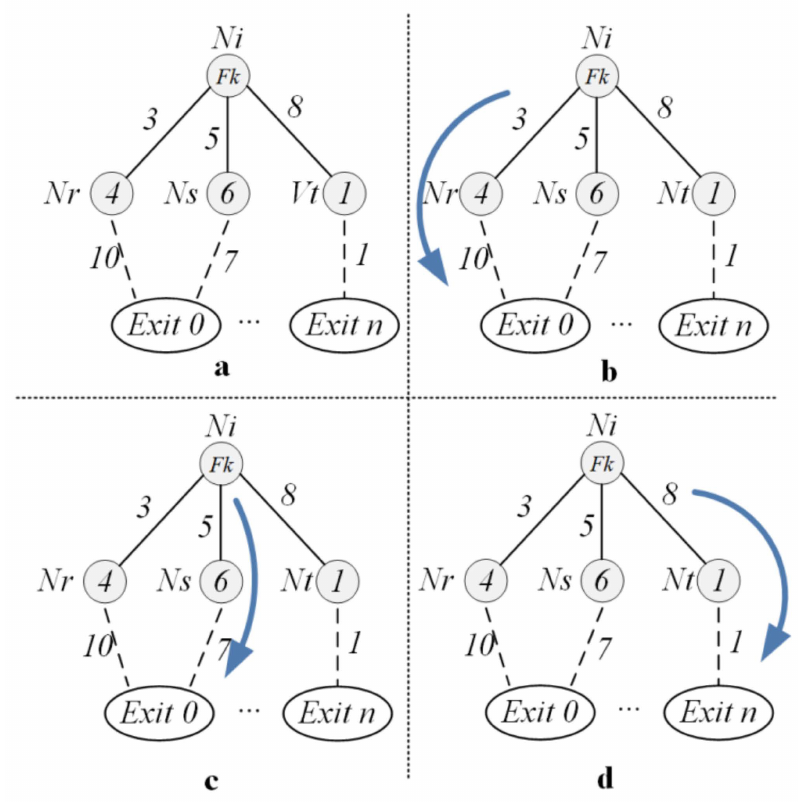
Figure 3. Behaviors of fish swarms and path selections. ( a ) Original diagram. ( b ) Preying. ( c ) Swarm- ing. ( d )